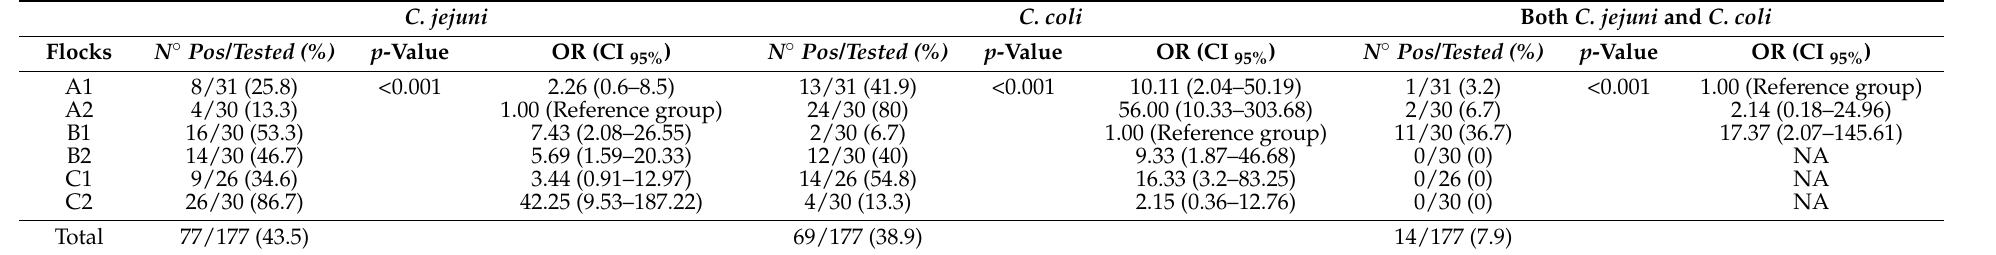
Table 3. Prevalence of C. jejuni and C. coli in flocks of laying hens housed in enriched cages (A1-A2), barns (B1-B2) and aviaries (C1-C2). C. jejuni C. coli Both C. jejuni and C.